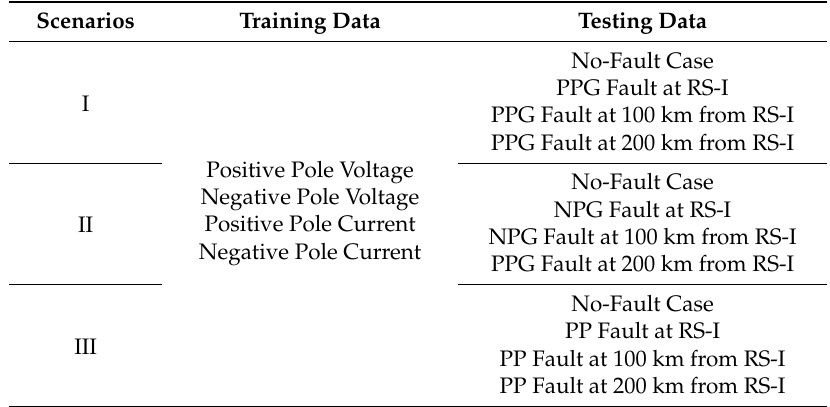
Table 2. Di ff erent cases for determination of fault location in the MT-HVDC test system.